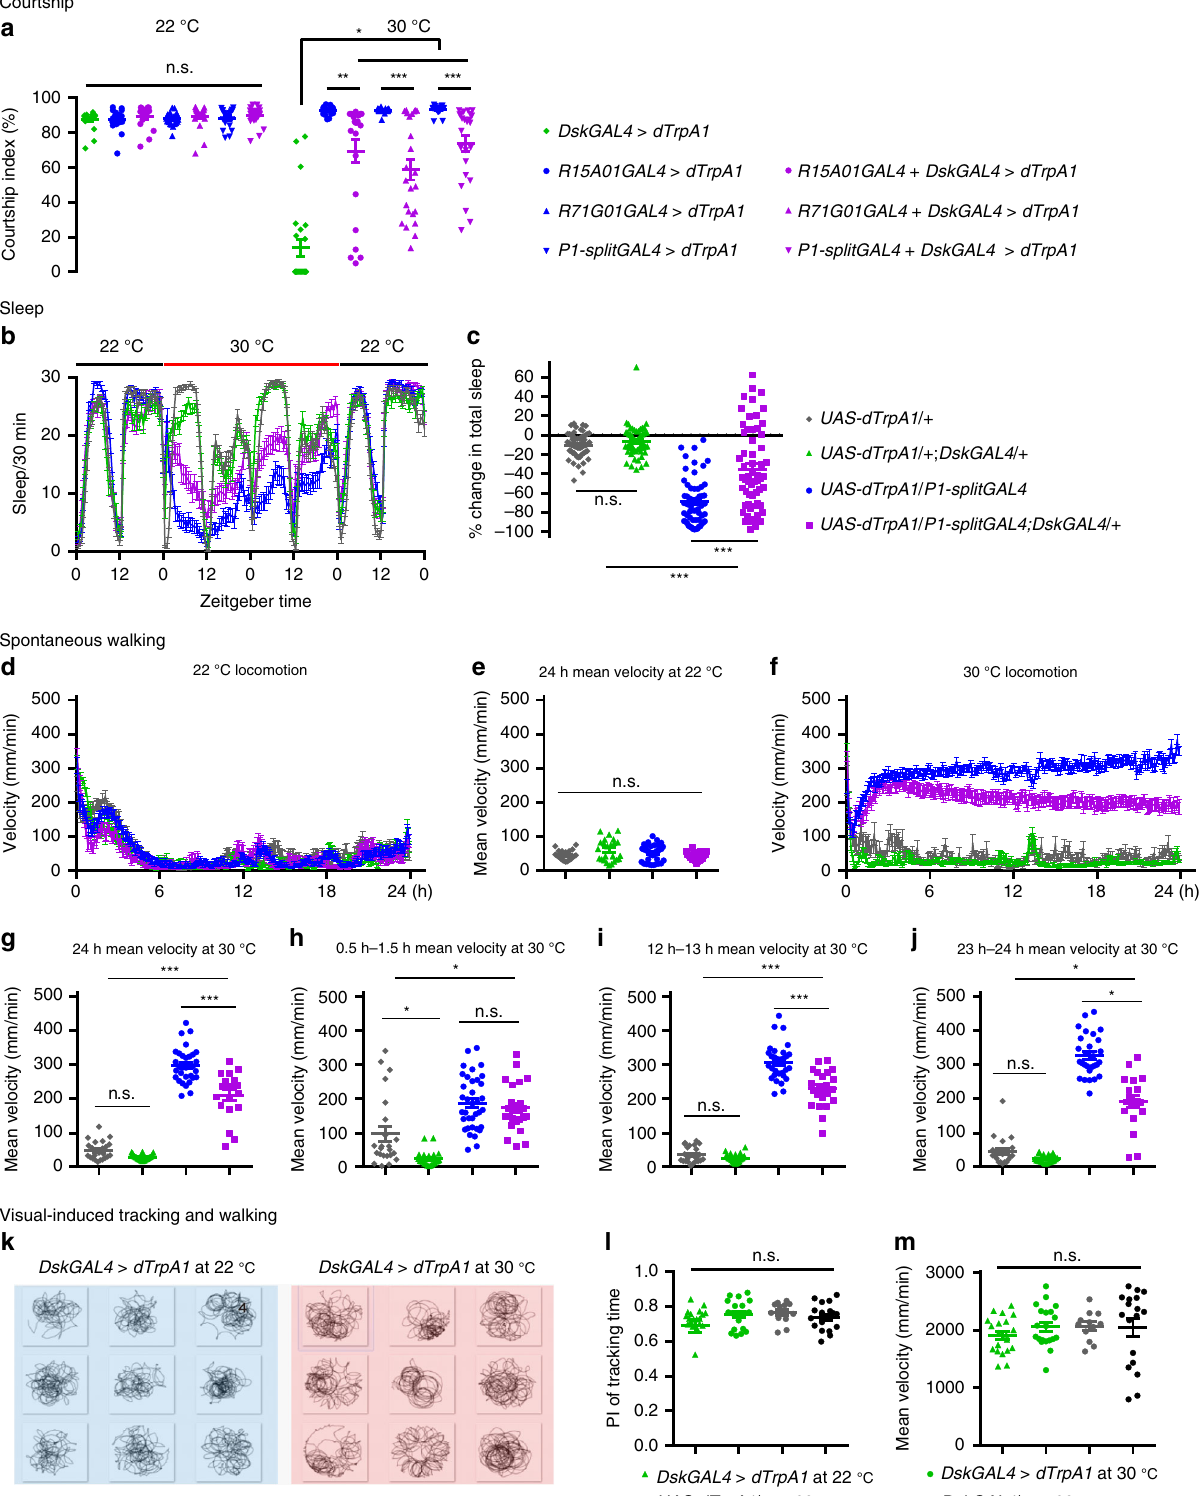
Visual-induced tracking and walking